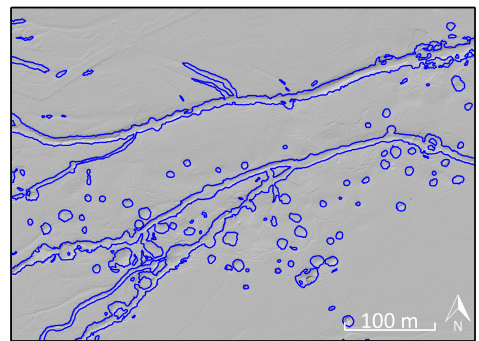
Figure 10. Delineation of gullies and sinkholes in Arav and Filin (2021). Note that the detection is a delineation